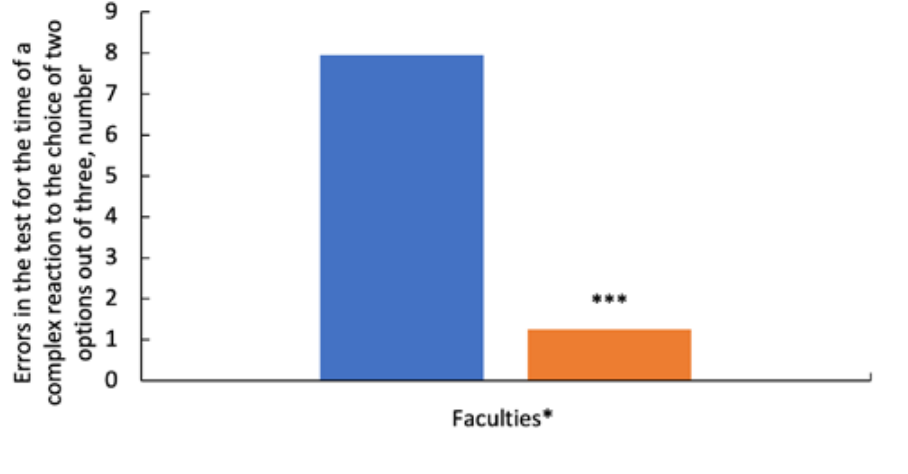
Figure 2. The number of errors in the test for the time of a complex reaction to the choice of two options out of three among students of the Faculty of Arts in comparison with students of other